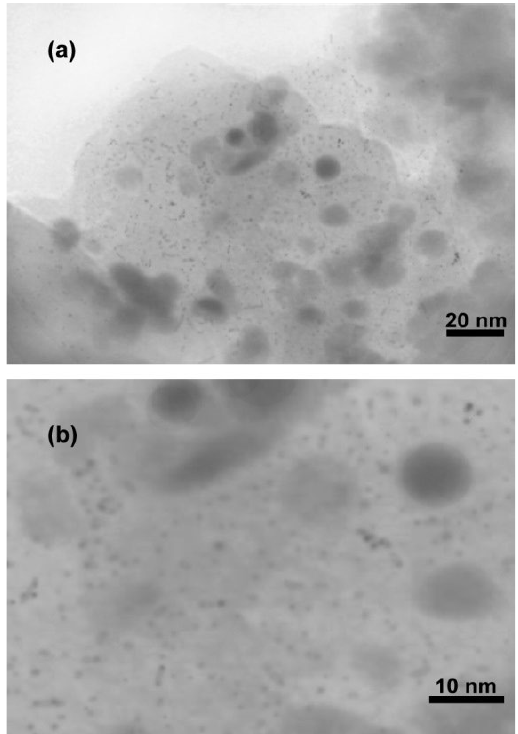
Fig. 5. TEM images of MNP/HPG-CA/Pd Figure 5 TEM images of MNP/HPG-CA/Pd bases including DBU, Et N, NaOH, NaHCO , 3 3 K PO and K CO . Among the screened bases, 3 4 2 3 Table 1. Optimization of Suzuki–Miyaura cross–coupling of 4–iodotoluene with phenylboronic acid catalyzed by MNP/HPG-CA/Pd a Table 1. Optimization of Suzuki–Miyaura cross-coupling of 4-iodotoluene with phenylboronic acid catalyzed by MNP/HPG-CA/Pd